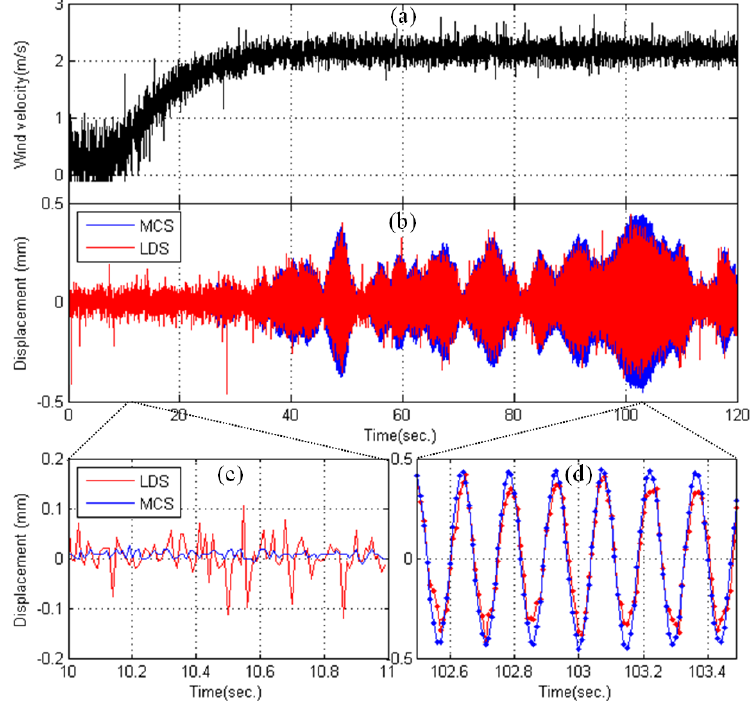
Figure 7. Observed test results. ( a ) Wind velocity; ( b ) Displacement responses (MCS vs. LDS); ( c ) Displacement responses from 10 s to 11 s; ( d ) Displacement responses from 102.5 s to 103.5